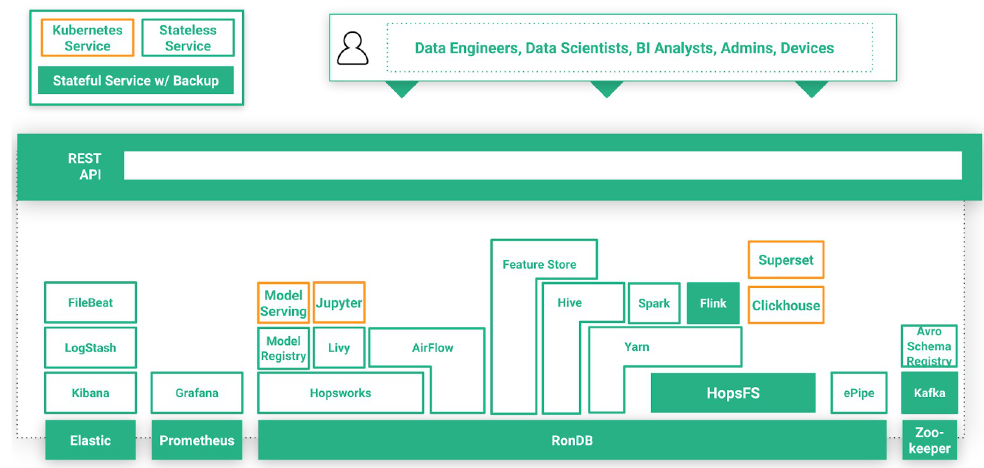
Figure 3. Hopsworks Services